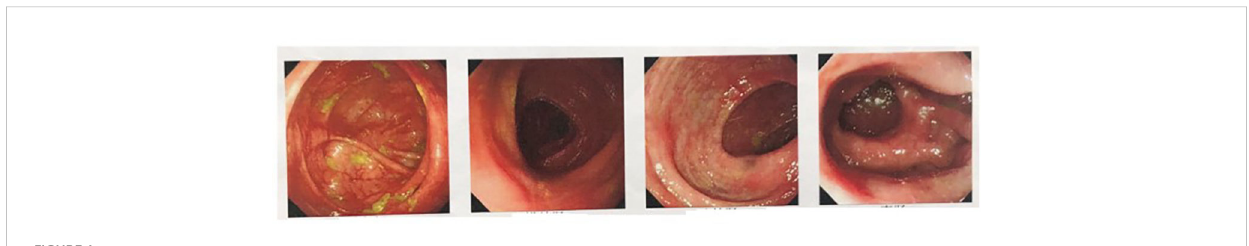
FIGURE 1 Multiple fl aky erosion of the colon sigmoid colon, mucosal hyperemia, and